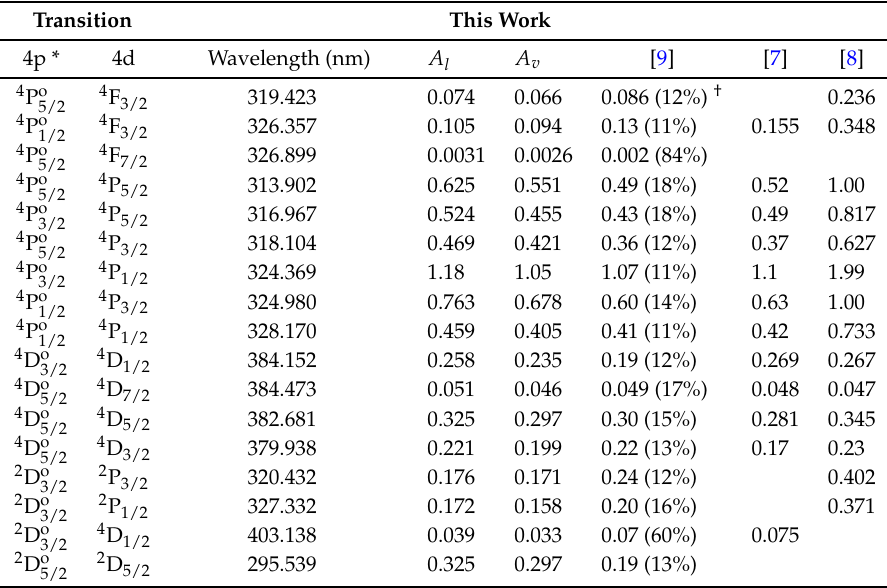
Table 3. A -values (10 8 s − 1 ) for 4p–4d transitions in Ar